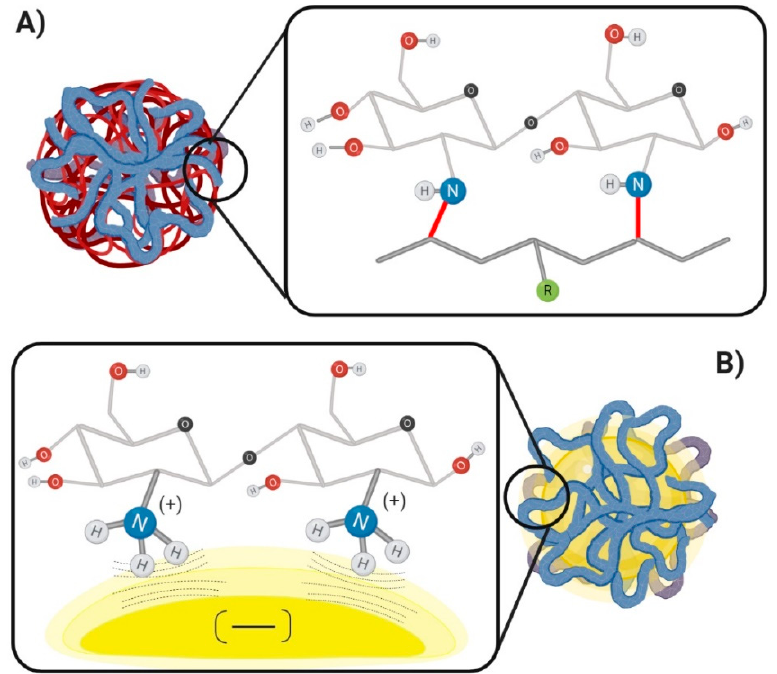
Figure 2. Chitosan coating mechanism. ( A ) Covalent mechanism: it is represented by the covalent bonds between the chitosan and a possible polymer (red bond). ( B ) Non-covalent mechanism: it is represented by the polar attraction forces between the cationic character on the chitosan chains and the anionic density on the nanoparticles.